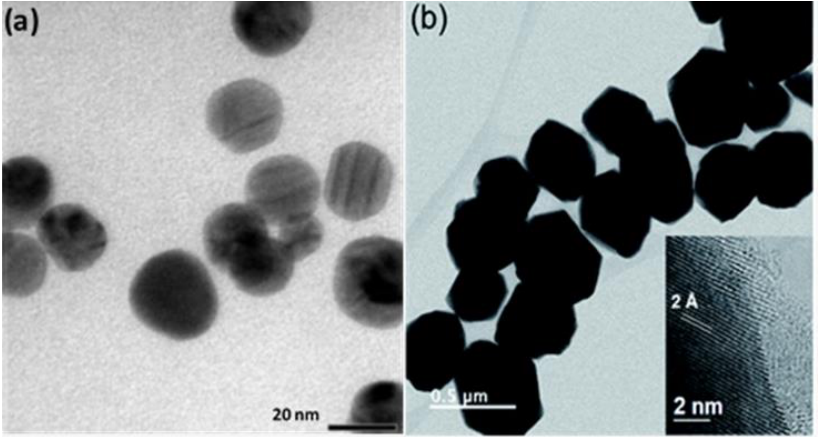
Figure 4. Cu nanoparticles synthesized with different shapes and sizes: ( a ) spherical shapes [158] and ( b ) faceted shapes